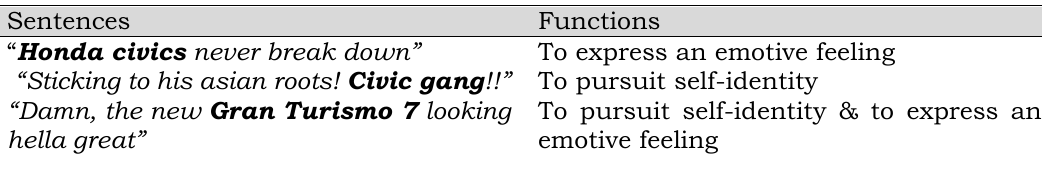
Table 6. Conversion word and the